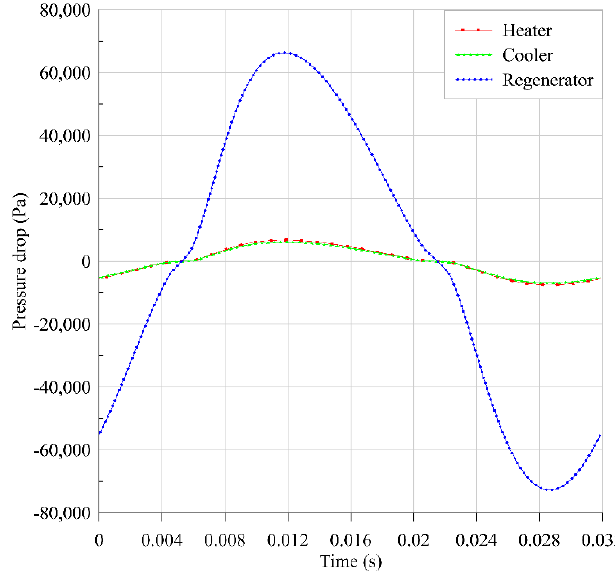
Figure 5. Pressure drops in the exchangers.